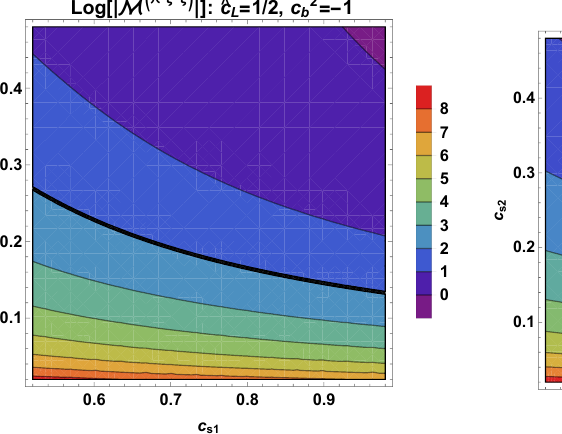
. B (tts) (cid:15) TTS